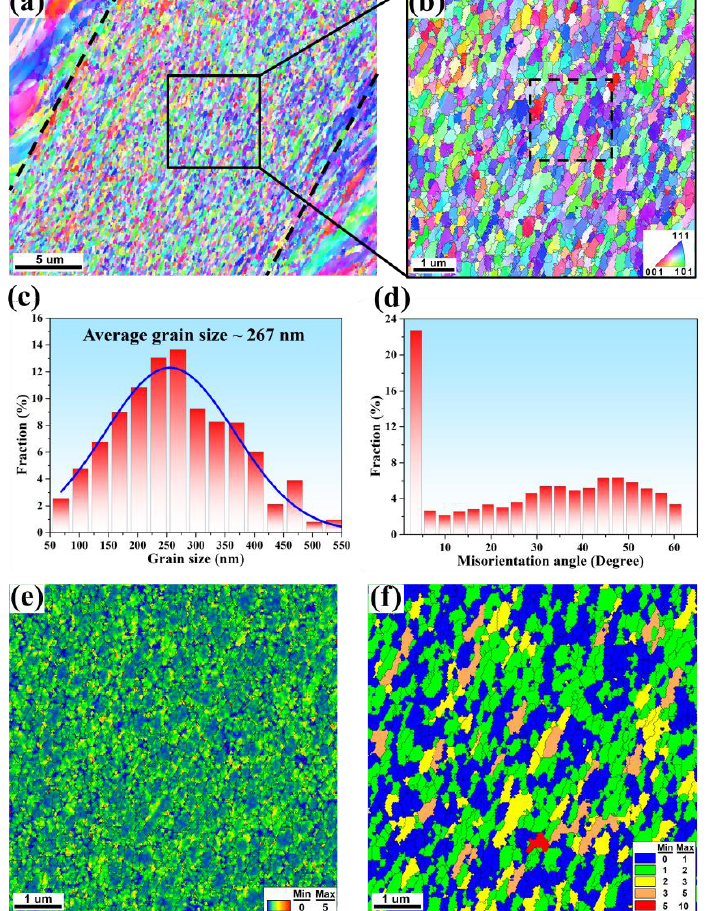
Figure 5. EBSD micrographs of the shear band (step size: 35 nm): ( a ) IPF orientation map; ( b ) IPF orientation map in center of shear band; ( c ) grain size distributions inside shear band; ( d ) grains’ misorientation angle distributions inside shear band; ( e ) KAM map superimposed by HAGBs; ( f ) GOS map superimposed by HAGBs.